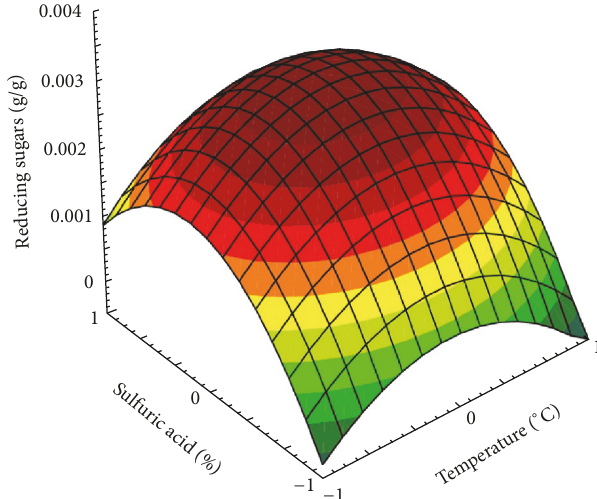
Figure 2: Influence of temperature ( ∘ C) and sulfuric acid concen- tration (%) on the generation of reducing